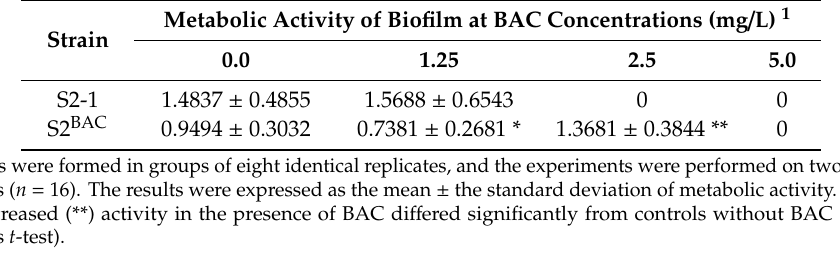
Table 2. E ff ect of benzalkonium chloride (BAC) on the prevention of biofilm formation by two strains of Listeria monocytogenes . The metabolic activities ( A 570 – A 600 ) of biofilms were quantified after incubation for 24 h using the resazurin reduction